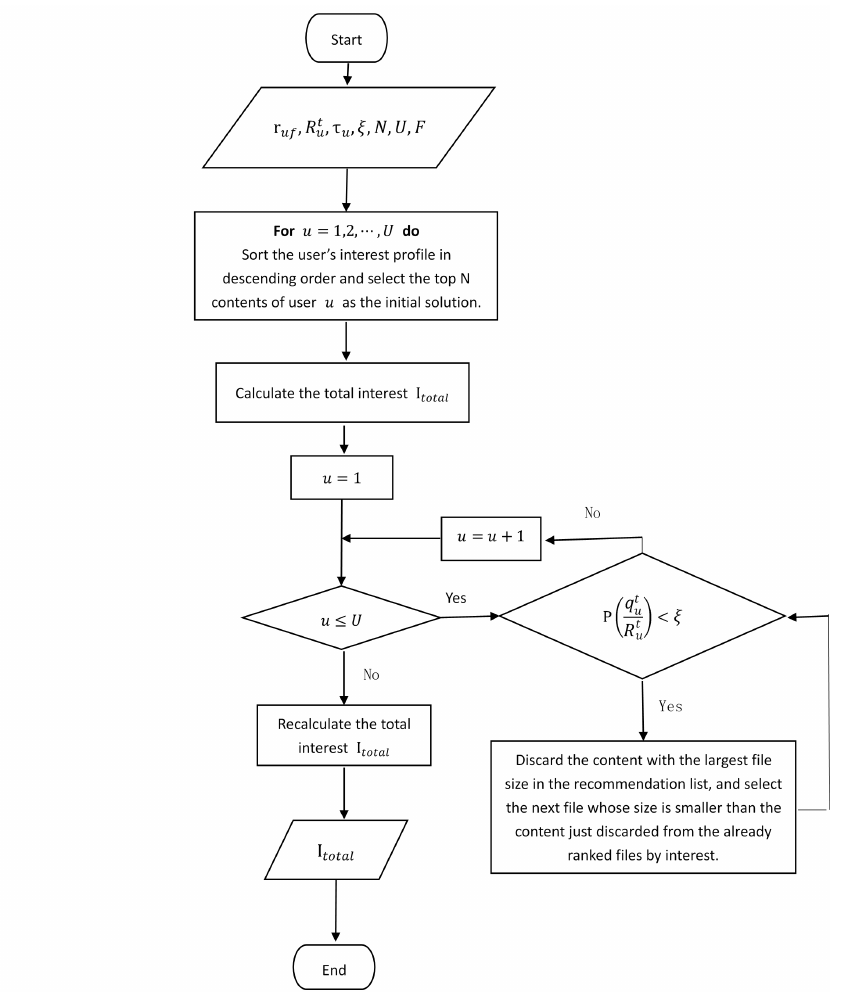
Figure 5. Proposed heuristic algorithm for content